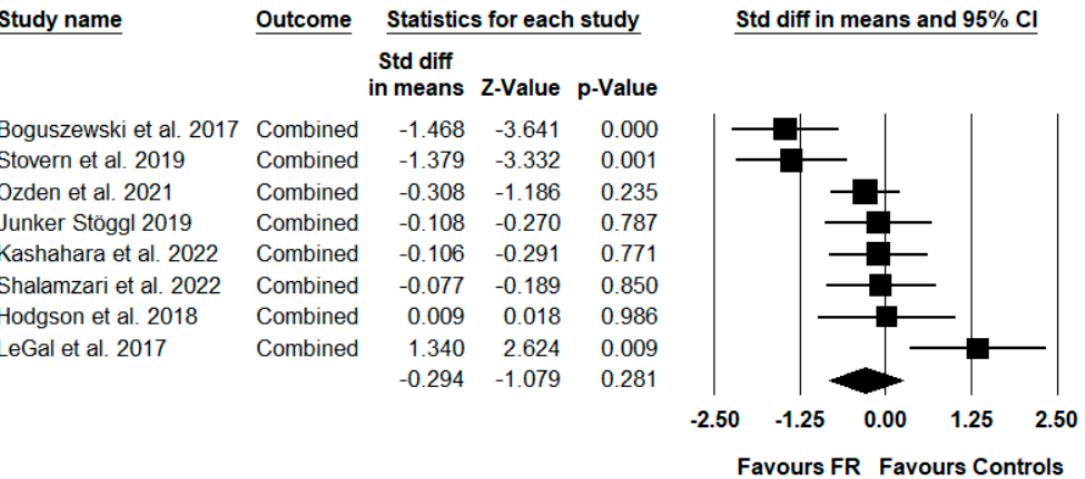
Figure 3. Forest plot presenting the eight included studies (squares) that investigated the effects of foam rolling (FR) on performance parameters (ROM) [26–33]. Std diff in means = standardized difference in means; CI = confidence interval; combined = mean of the selected outcomes of one study. Diamond represents mean standard difference in means of the eight studies.